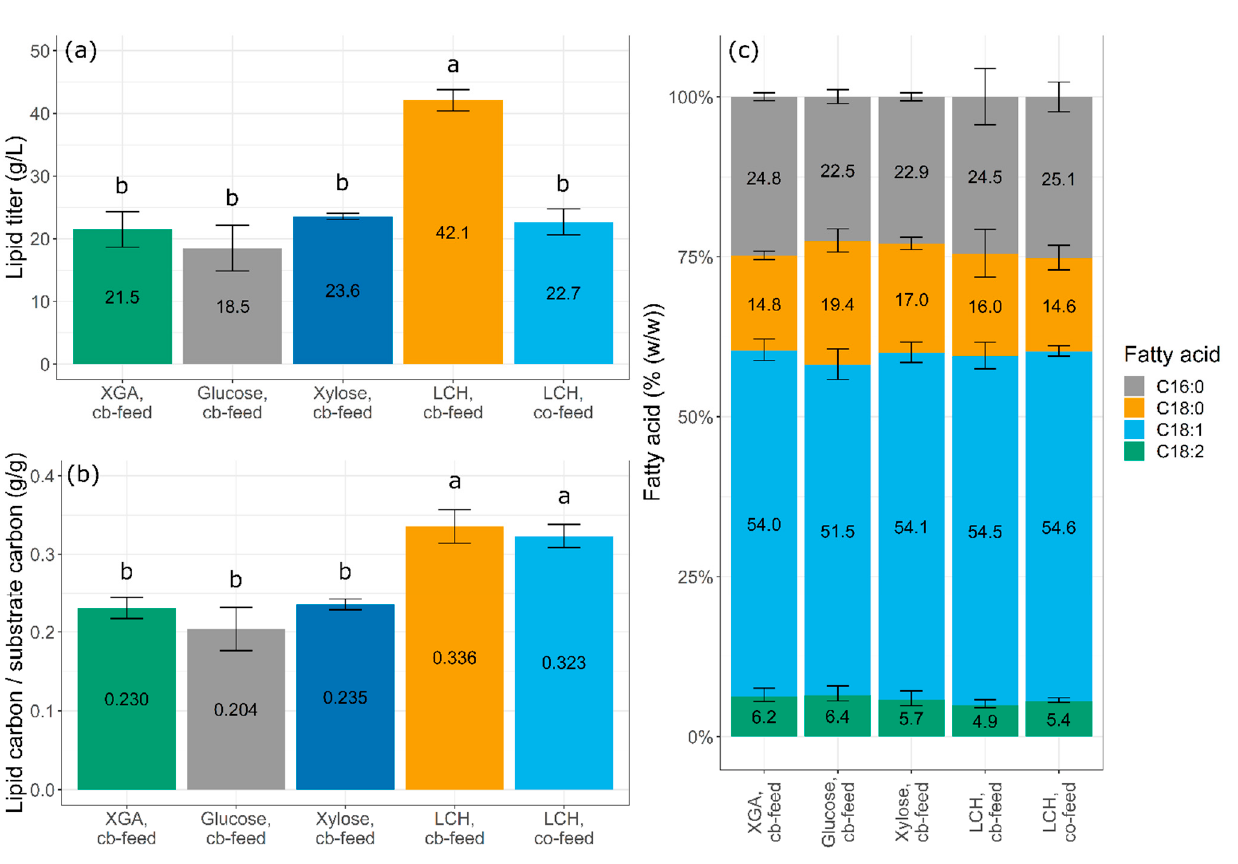
Figure 2. Lipid analysis of the four most important fermentation conditions. ( a ) Lipid titers after 71 h fermentation in 1 L scale. ( b ) Carbon conversion yield from substrate carbon to lipid carbon. ( c ) fatty acid profile of the main fatty acids quantified with GC-FID. Error bars display two times standard deviation; Duncan tests were performed with p < 0.01 to determine statistical groups a and b for lipid titer and carbon conversion, Duncan results for the fatty acid profile are shown in the Table S3. cb-feed—consumption-based acetic acid feed; LCH—lignocellulosic hydrolysate; LCH co-feed—lignocellulosic hydrolysate as starting carbon, and constant feed with cb-feed. 3.5. Acetic Acid-Based Fermentation of Lignocellulosic Hydrolysate at